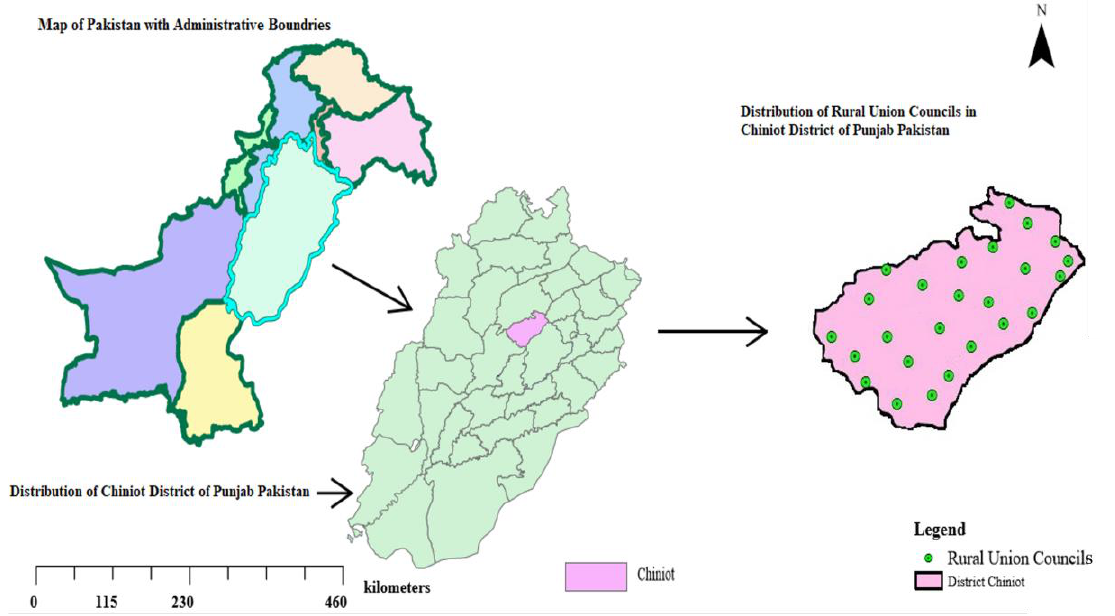
Figure 1. Map of the study area indicating the distribution of sampling